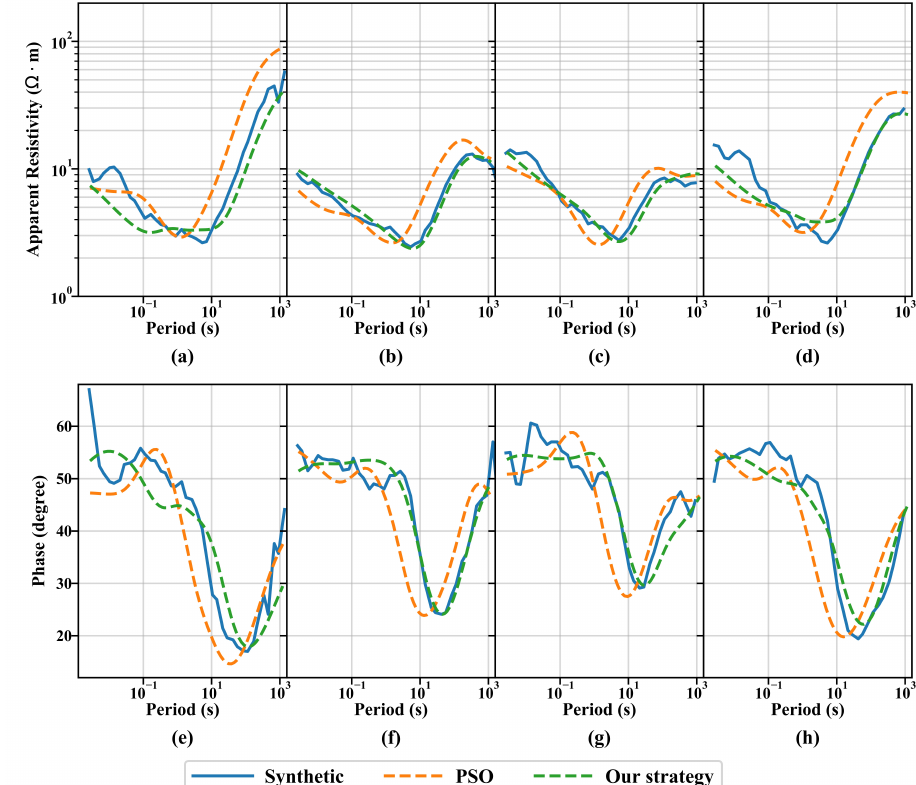
Figure 14. Comparison of the predicted and measured responses in XY mode. ( a – d ) represent the apparent resistivity response curves, and ( e – h ) represent the phase response curves. ( a , e ) represent the response curves of the fifth observation station, ( b , f ) represent the response curves of the tenth observation station, ( c , g ) represent the response curves of the 15th observation station, and ( d , h ) represent the response curves of the 20th observation station. The blue lines represent the measured response curves. The yellow lines represent the response curves predicted by traditional PSO. The yellow lines represent the response curves predicted by the proposed memetic